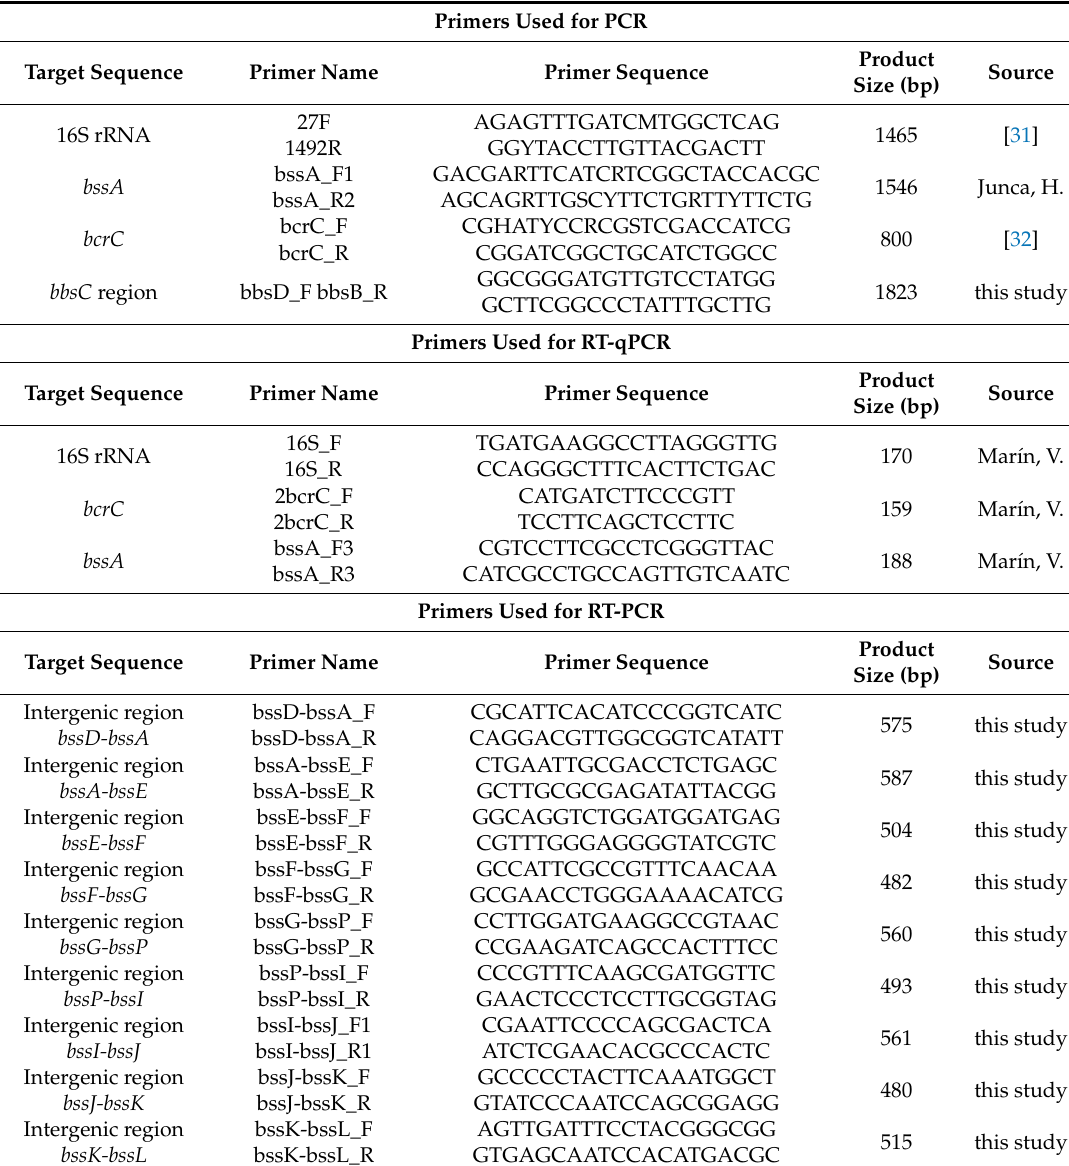
Table 1. Primers used in this